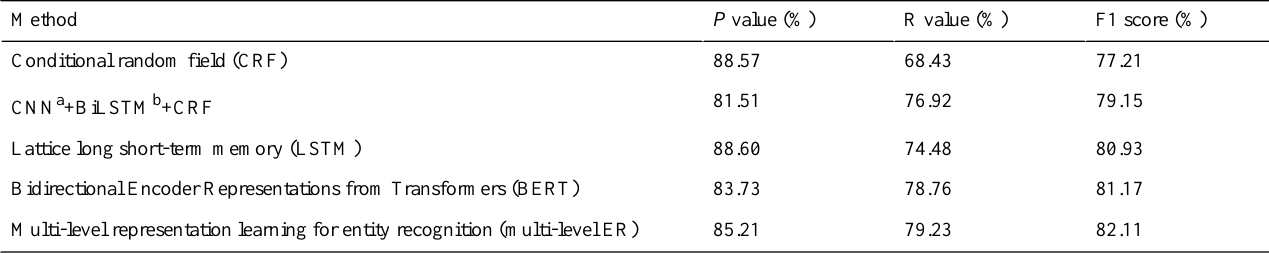
Table 3. Comparison of method performance on the Chinese electronic medical record (CEMR)